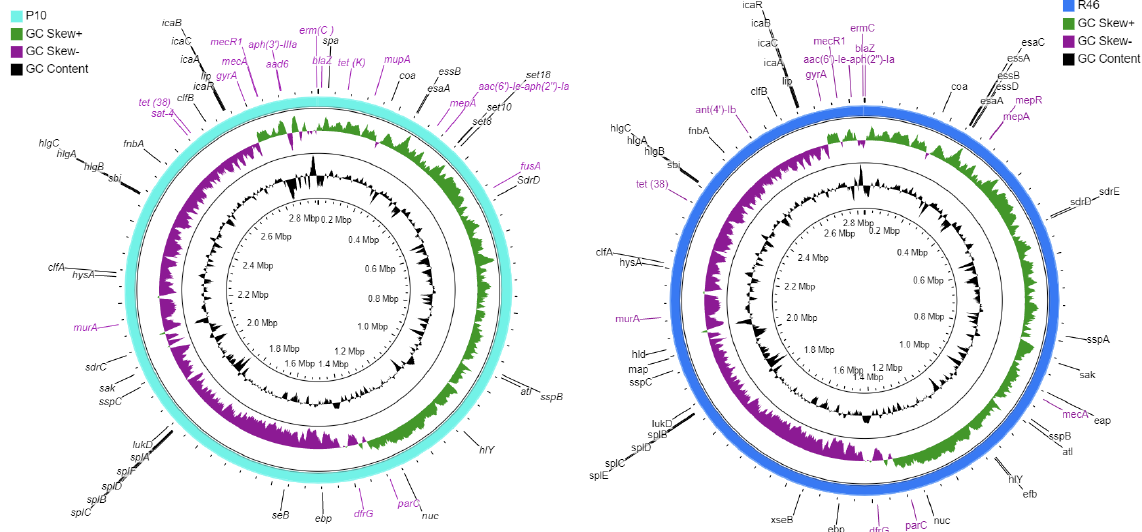
Figure 1. Circular visualization of P10 and R46 genomes via CGViewer, showing antibiotic resistance determinants (labeled in purple) and virulence genes (labeled in